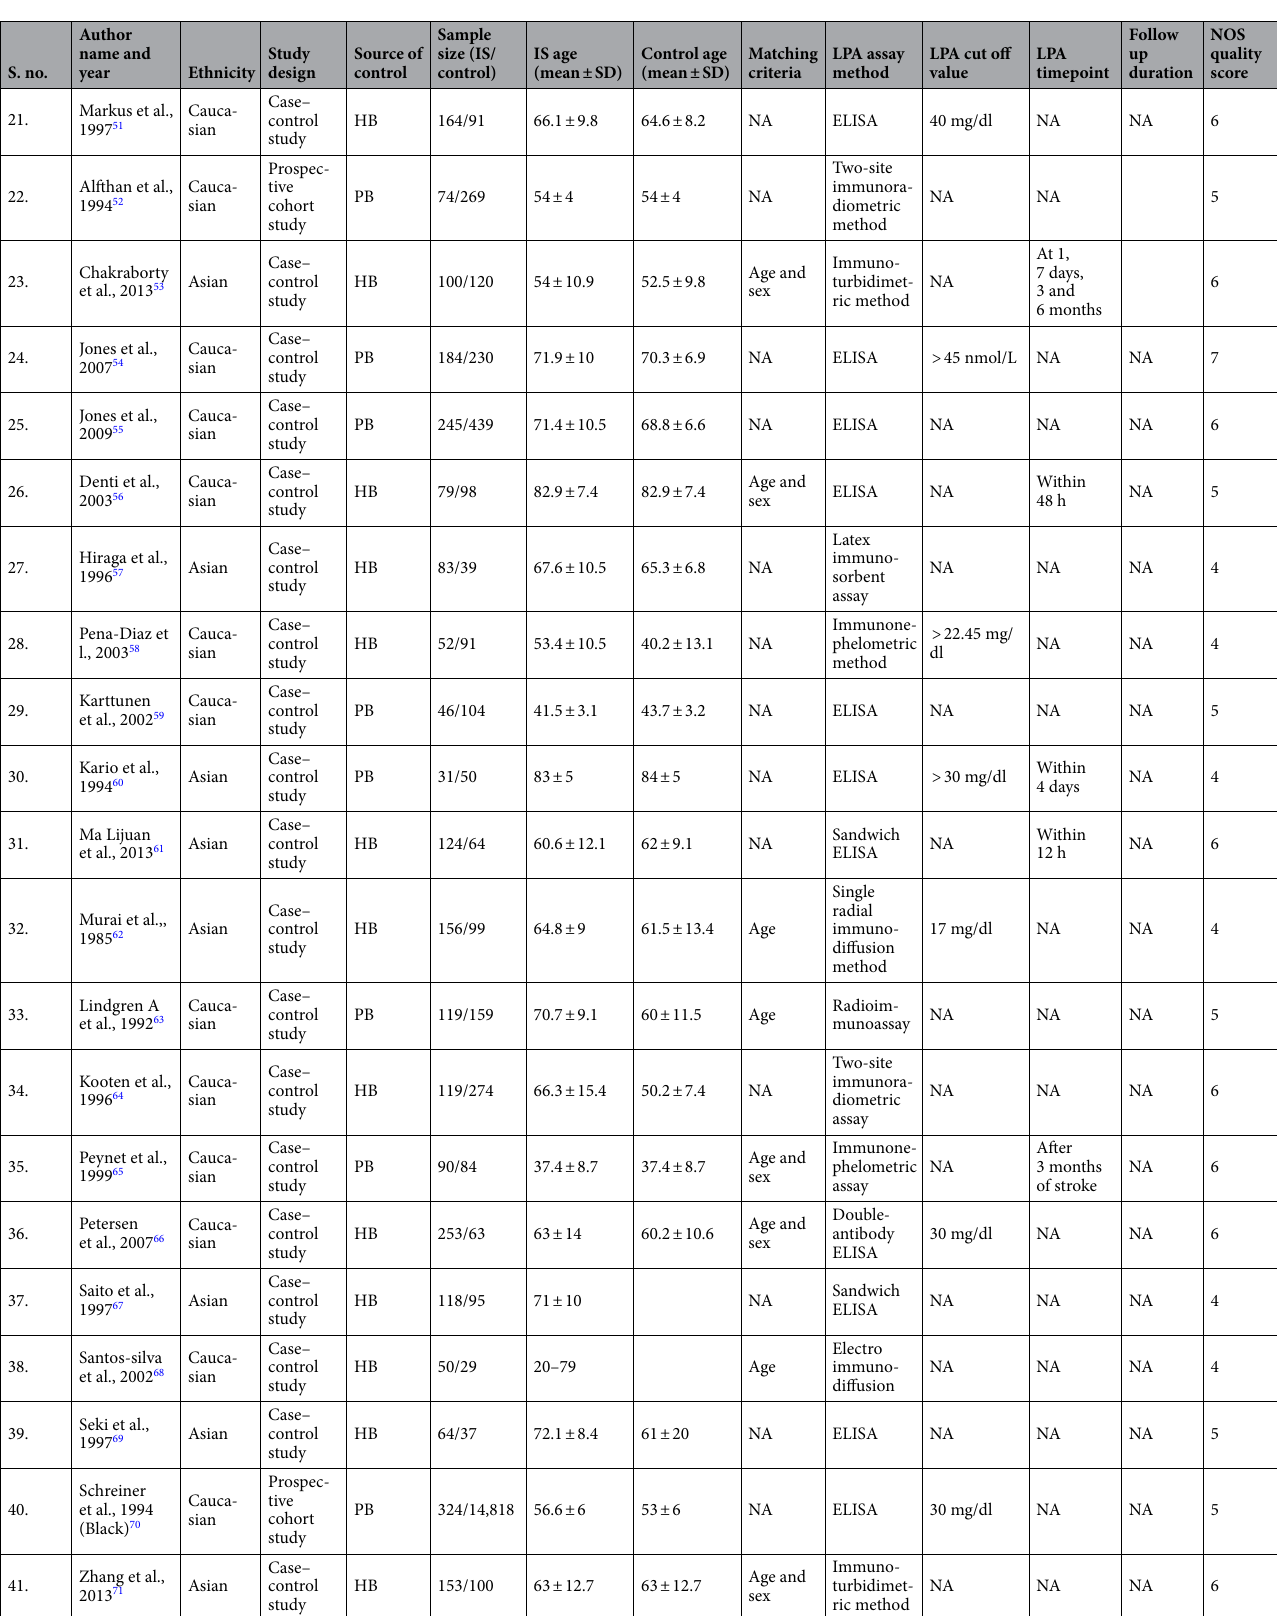
Table 1. Baseline characteristics of studies included in the systematic review and meta-analysis for the relationship between serum Lp (a) levels and risk of ischemic